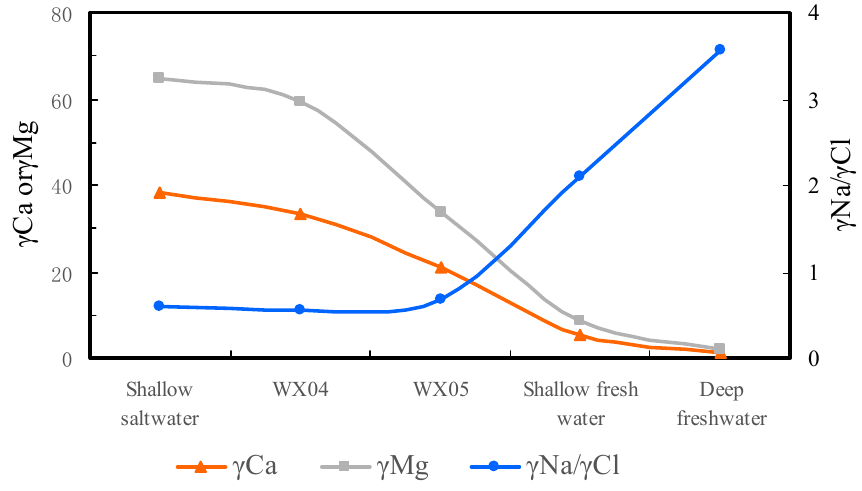
Figure 8. γ Mg, γ Ca and γ Na/ γ Cl for different types of groundwater.